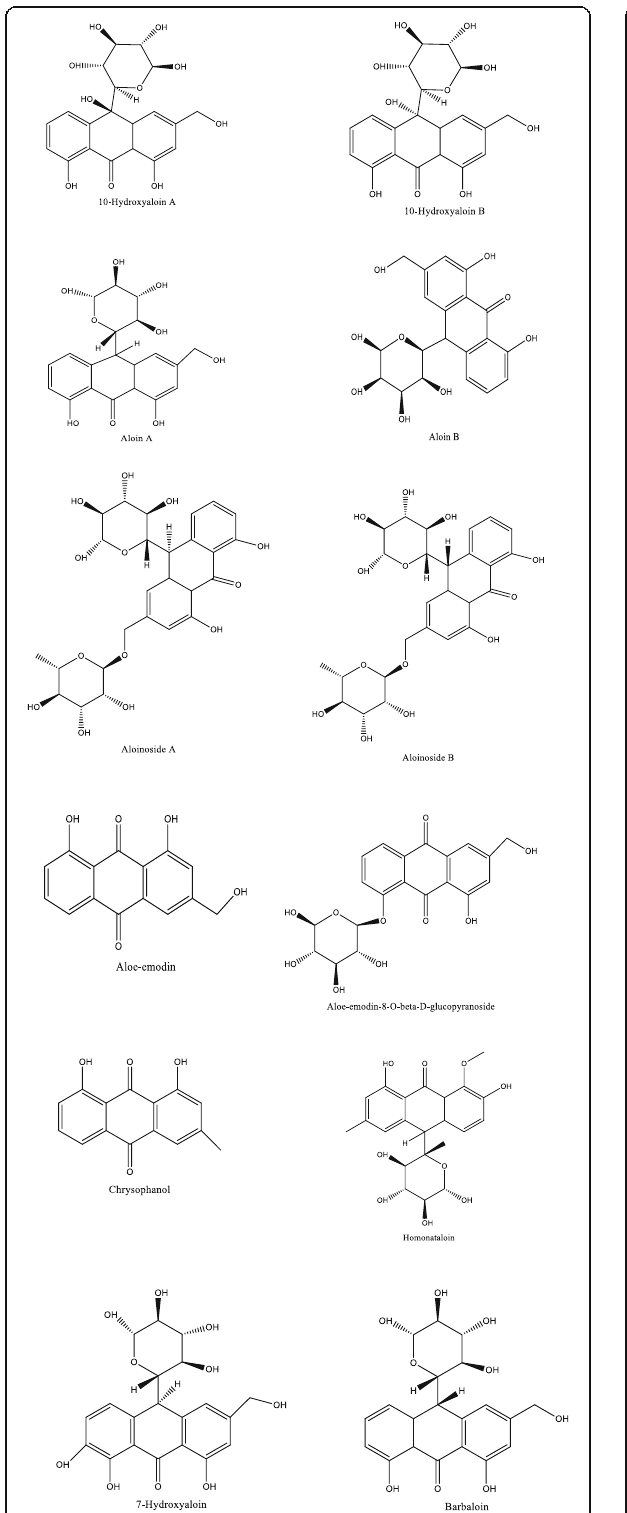
Fig. 4 Chemical structures of flavonoids isolated from A. vera and A.